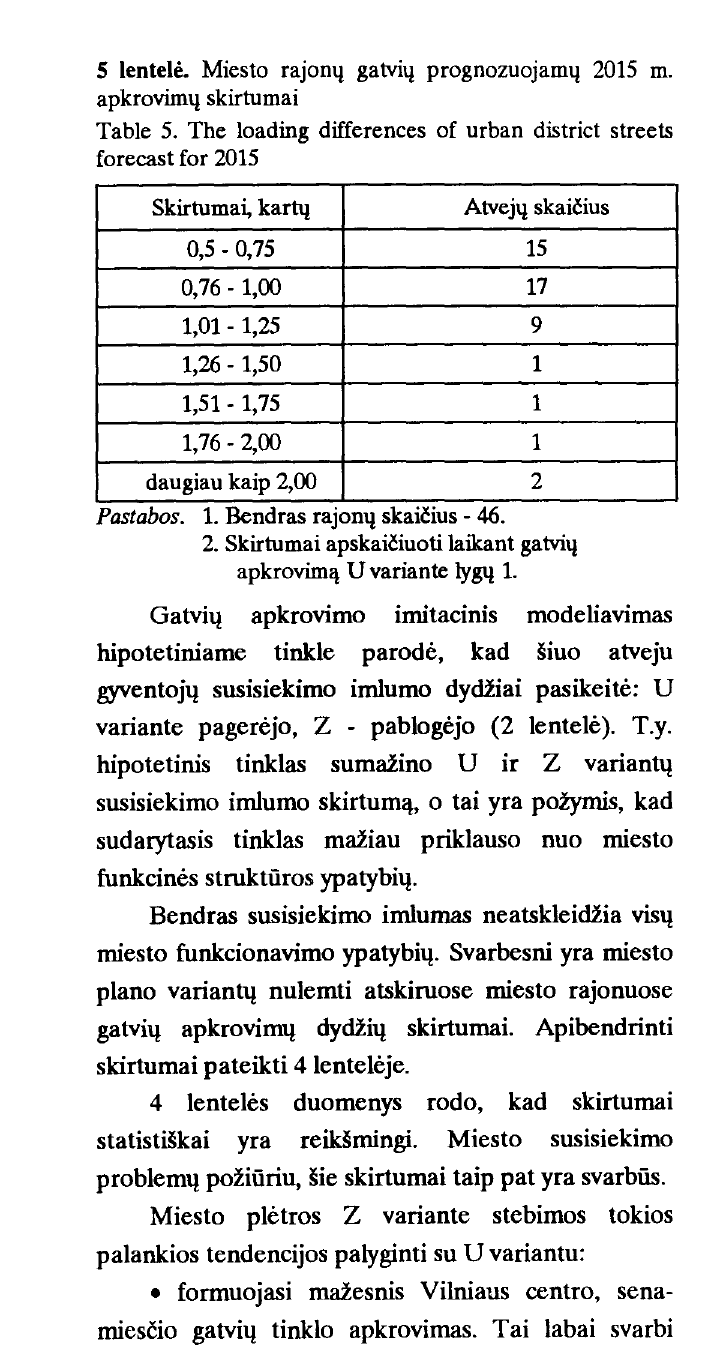
Table 5. The loading differences of urban district streets forecast for 2015